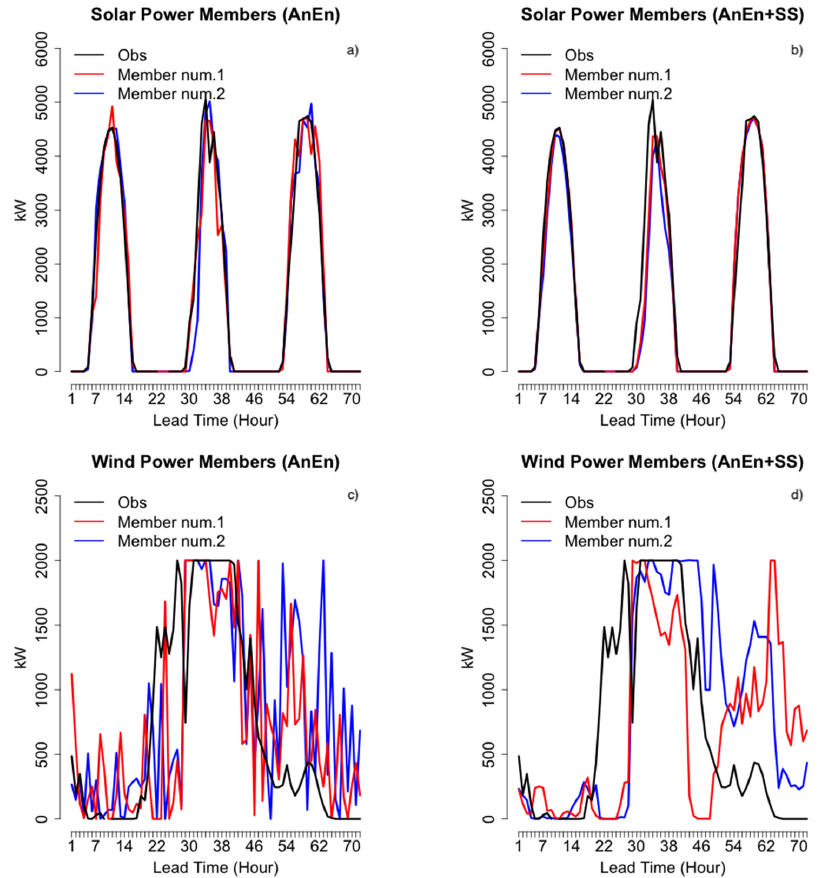
Figure 4. Example of solar power and wind power predictions from 2 randomly selected analog ensemble (AnEn), ( a , c ) and AnEn + Schaake shuffle (SS), ( b , d ) ensemble members.